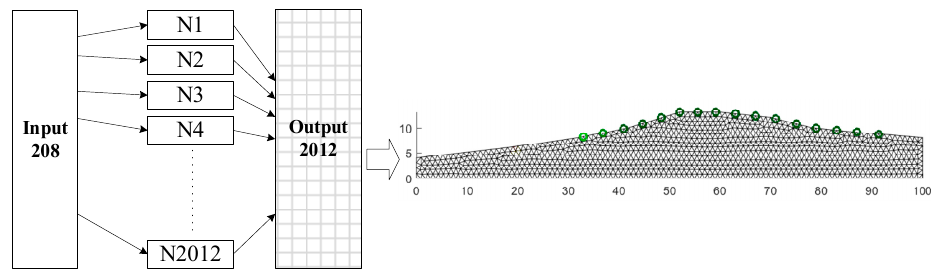
Figure 10. Model of a neural network cluster generating 2012-point resolution output image.